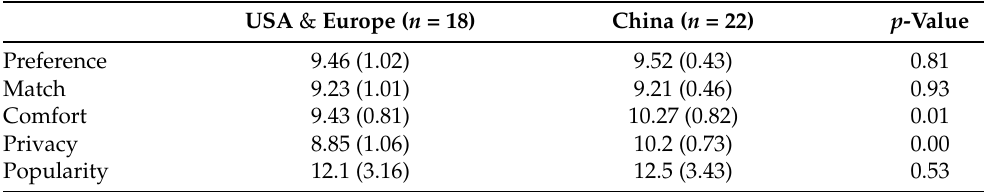
Table 8. Ratings a for the proposed microgestures for participants from the US and Europe and from China.